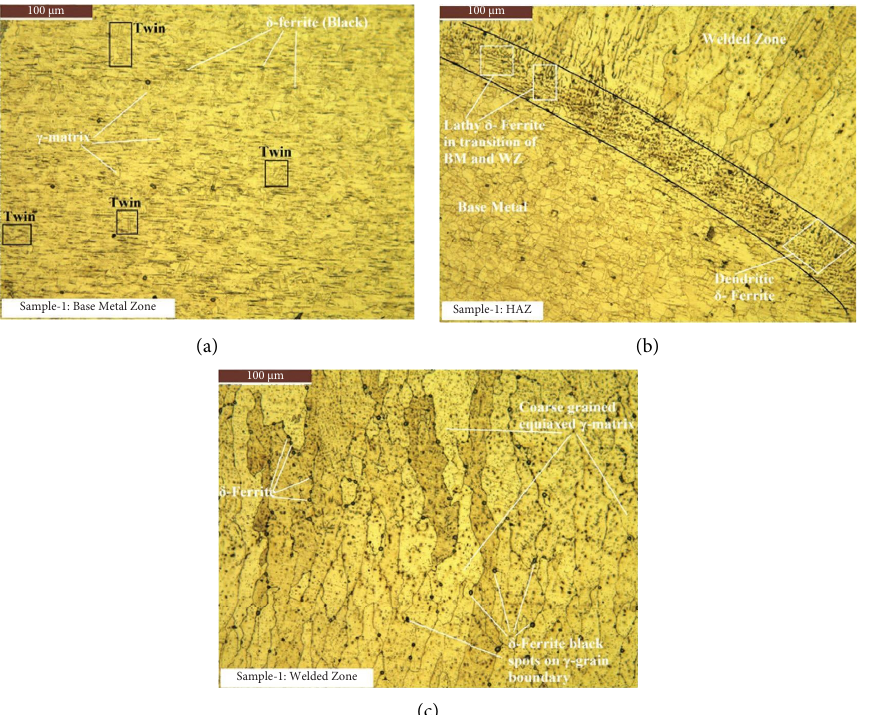
Figure 5: Microstructural appearance of sample 1 (original sample): (a) the base metal, (b) HAZ, and (c) welded